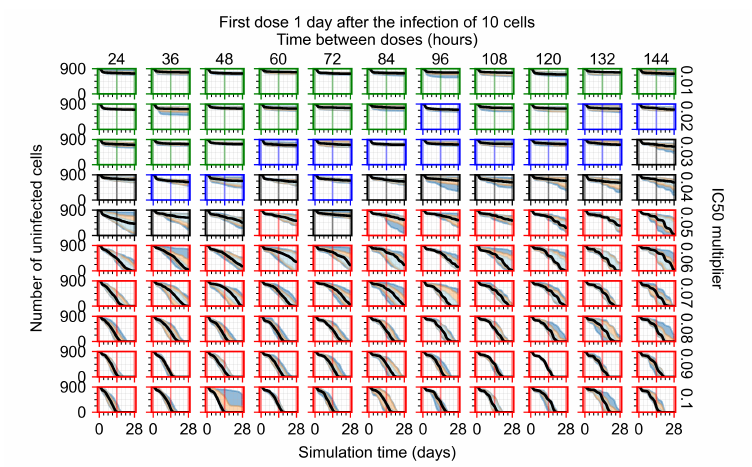
Figure A91. Uninfected